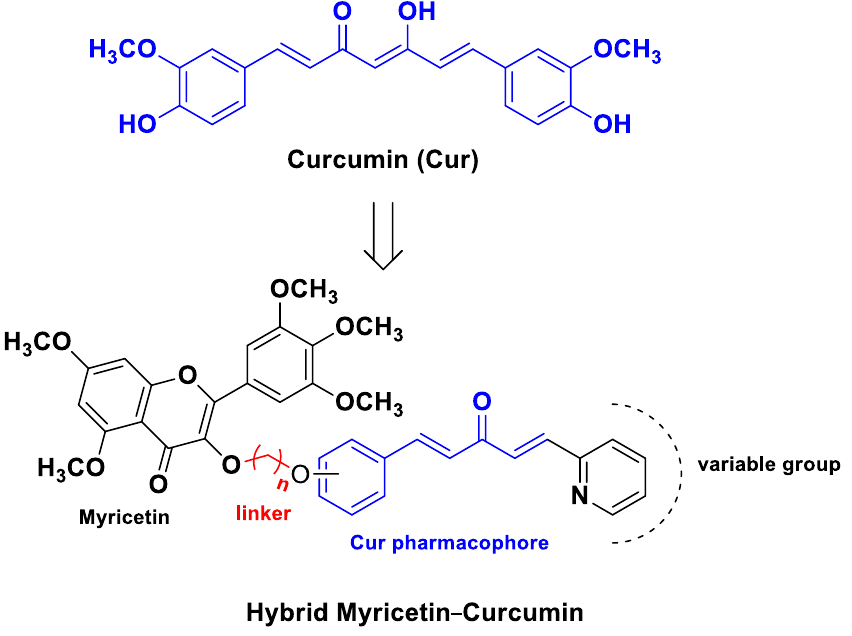
Figure 3. Myricetin – Cur hybrids developed by Wang et al. [63]. For the most active compound, n =